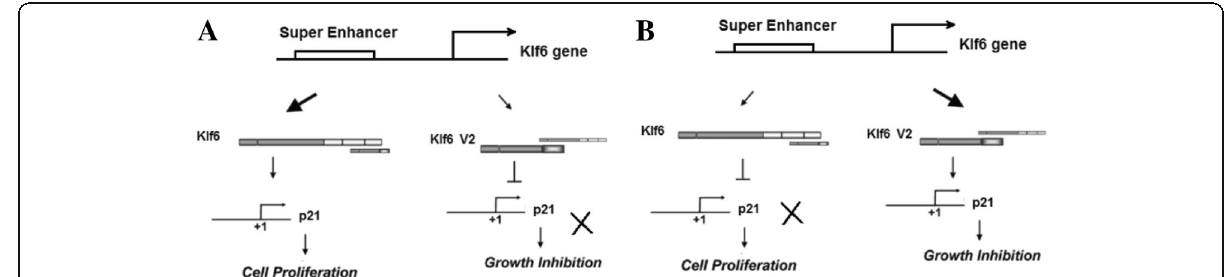
Fig. 6 The model regulating cell proliferation by super enhancer. a Pre-disruption model of Klf6 -related SE. When Klf6 -related SE is not disrupted, it upregulates Klf6 expression and induces cellular proliferation. b Post-disruption model of Klf6 -related SE. When Klf6 -related SE is disrupted, it upregulates Klf6-SV2 expression which leads to p21 -mediated growth inhibition. The size of the arrow in the figure represents the relative expression intensity of the target gene. In other words, an arrow indicated by a thick line means strong gene expression compared to a thinly marked